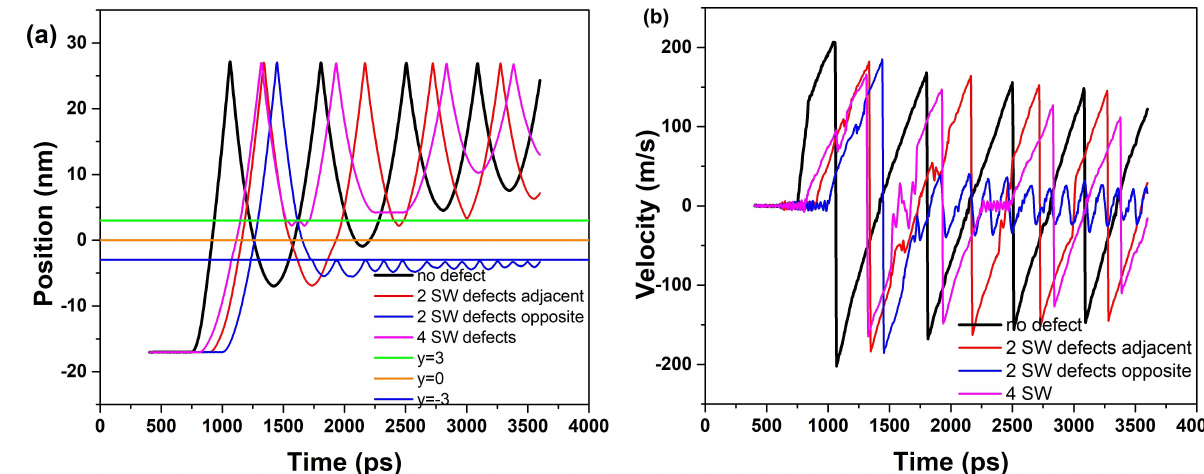
Figure 8: Variation of the movement behaviors with time for the system containing no defect, 2 SW defects adjacent, 2 SW defects opposite, 4 SW defects in the inner nanotube: (a) The position with time. (b) The velocity with time